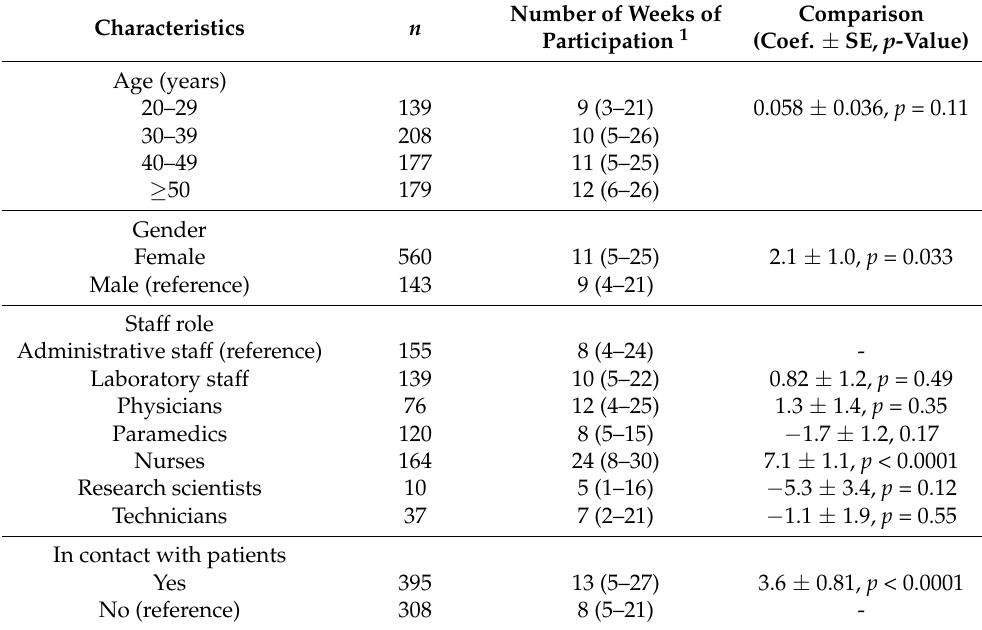
Table 2. Adherence to the study protocol.